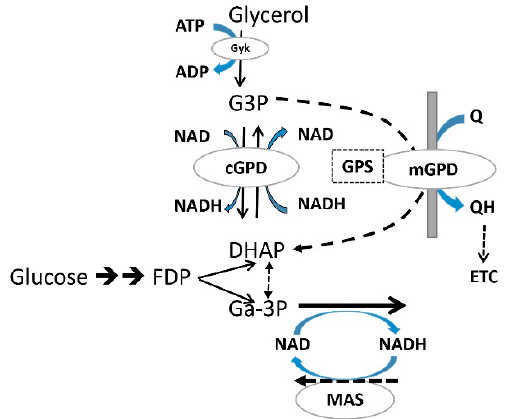
Figure 3. Metabolic pathways linked to glycerol 3-P formation in liver. G3P is generated from glycerol phosphorylation by glycerokinase or from DHAP, an intermediate of glycolysis and gluconeogenesis by cGPD, which catalyses the reversible NADH / NAD linked interconversion of DHAP and G3P; mGPD on the outer surface of the mitochondrial innermembrane catalyses irreversible oxidation of G3P coupled to the transfer of electrons to ubiquinone in the respiratory chain.